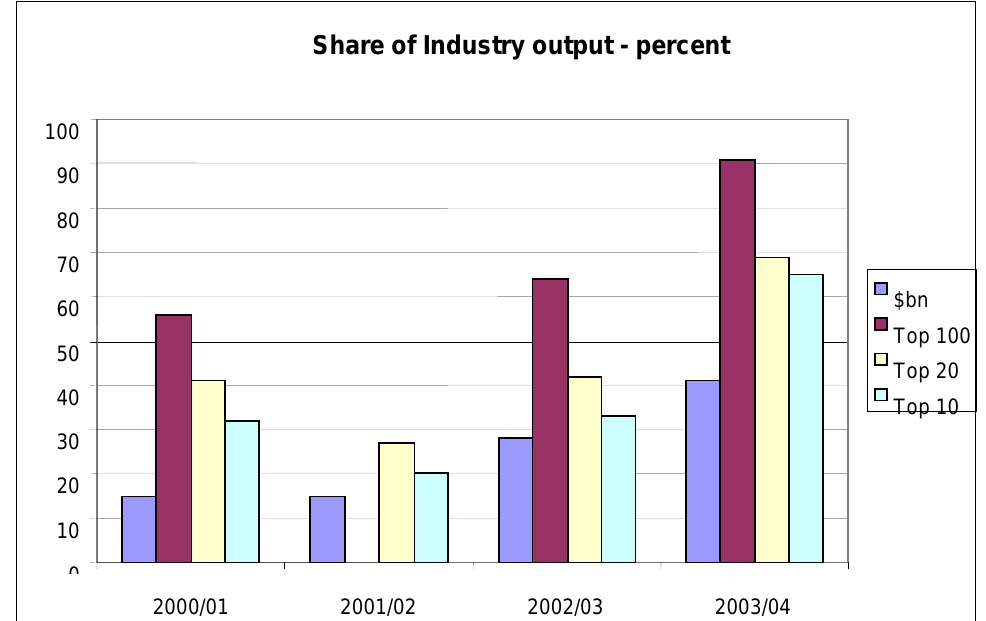
Figure 1. Australian Construction Industry Output and Turnover of Largest Firms (Source: Construction 100 : Australia’s 100 largest commercial contractors , HIA-Reed Construction Data, various